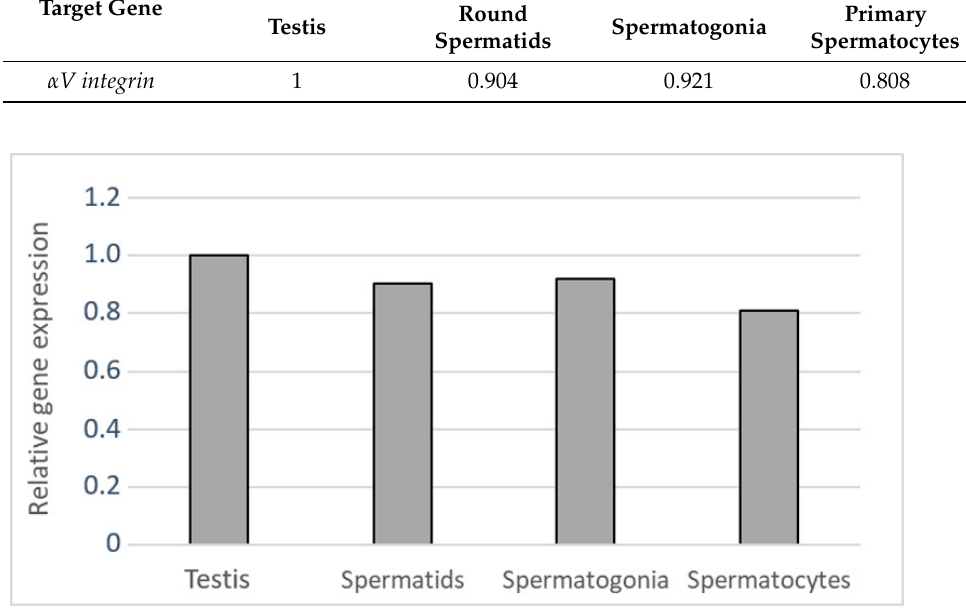
Table 1. Gene expression of α V integrin in the cell-type fractions. Cq value of the gene is normalized by reference gene Rps2 .